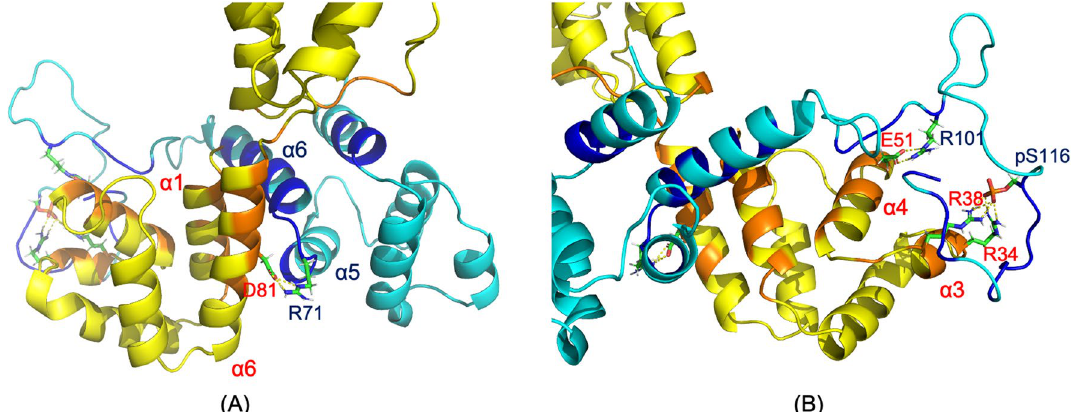
Figure 5. Binding interfaces in the simulated PEA-15pp/FADD complex. PEA-15pp is shown in cyan and FADD is shown in yellow. Interface residues on PEA-15 are colored in blue and residues on FADD are colored in orange. ( A ) DED-DED interface between PEA-15pp α5/α6 and FADD α1/α6, including direct interaction between PEA-15 R71 and FADD D81. ( B ) Interface between PEA-15pp C-terminal tail and FADD helices α3/ α4, including direct interactions between PEA-15 R101 and FADD E51, and the strong interactions between PEA-15pp p-S116 and FADD R38 and R38. The molecular structures were visualized and generated using PyMOL version 2.4 (http:// www. pymol.